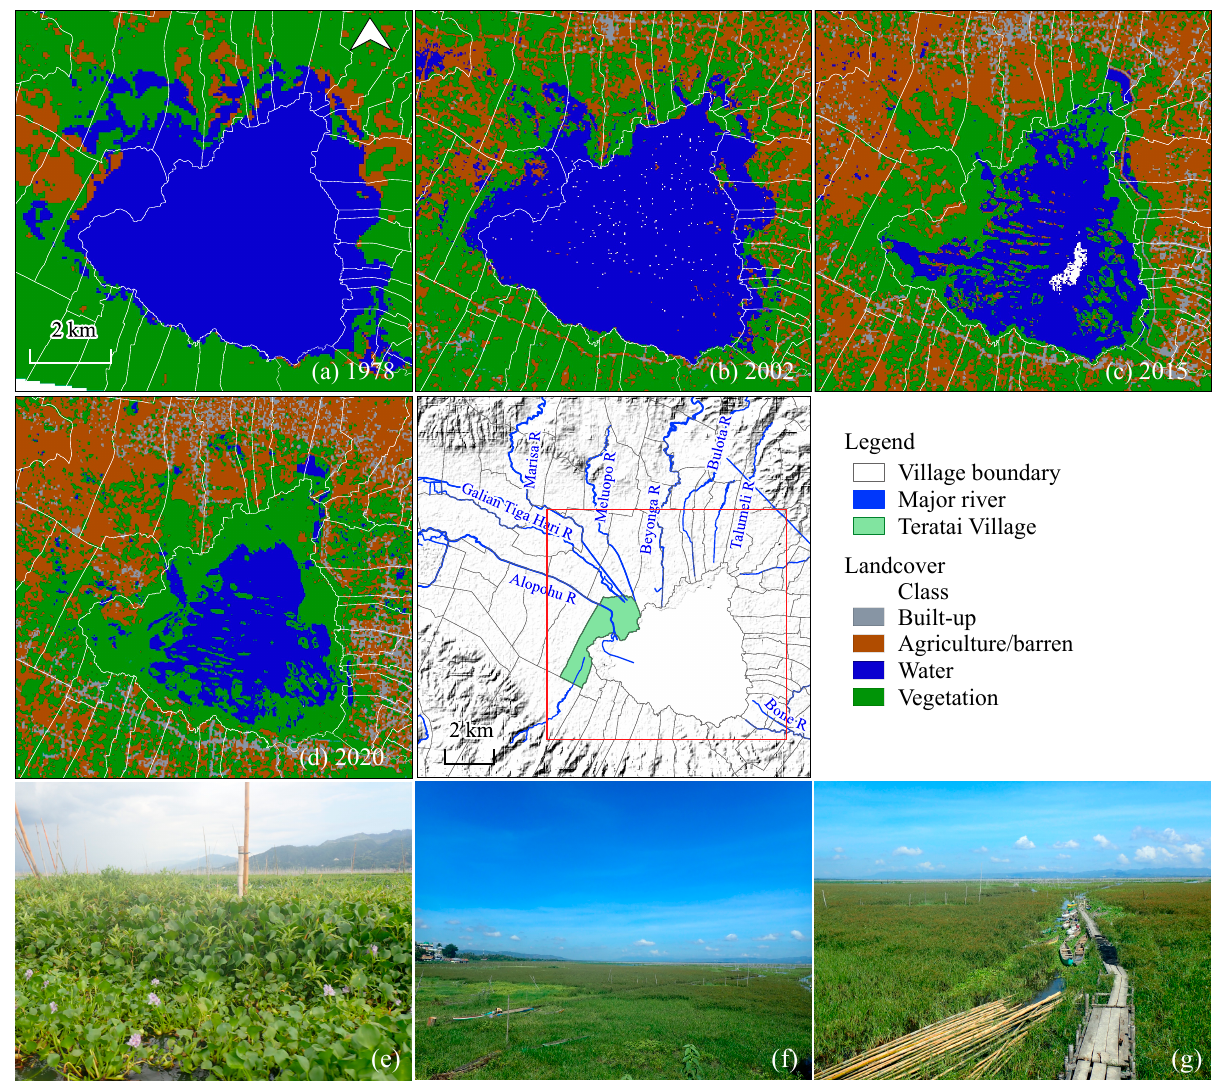
Figure 3. Landcover transformations in the lake’s surrounding areas: ( a – d ) landcover classification using Landsat series (1978–2020) and ( e – g ) water hyacinth growth on/at the lake in 2020.